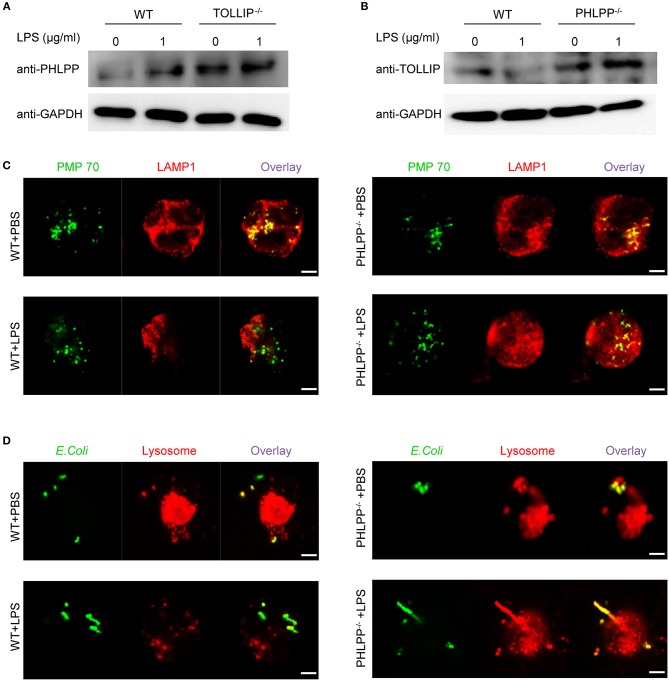
PHLPP antagonizes the function of TOLLIP and modulates lysosome fusion. (A) Immunoblotting of purified neutrophils from bone marrow of WT or TOLLIP−/− mice stimulated with LPS (1 μg/ml) or PBS as control overnight. (B) Immunoblotting of purified neutrophils from bone marrow of WT or PHLPP−/− mice stimulated with LPS (1 μg/ml) or PBS as control overnight. (C) WT or PHLPP−/− neutrophils were treated with PBS or LPS overnight, followed by staining with anti-PMP70 and anti-LAMP1 antibodies. The fusion of peroxisomes with lysosomes was visualized via confocal microscopy. (D) WT or PHLPP−/− neutrophils were co-cultured with FITC-labeled E.coli for 1 h, and lysosomes were stained with LysoTracker™ Red DND-99. The delivery of E.coli into lysosomes was visualized via confocal microscopy. Scale bar = 2 μm.